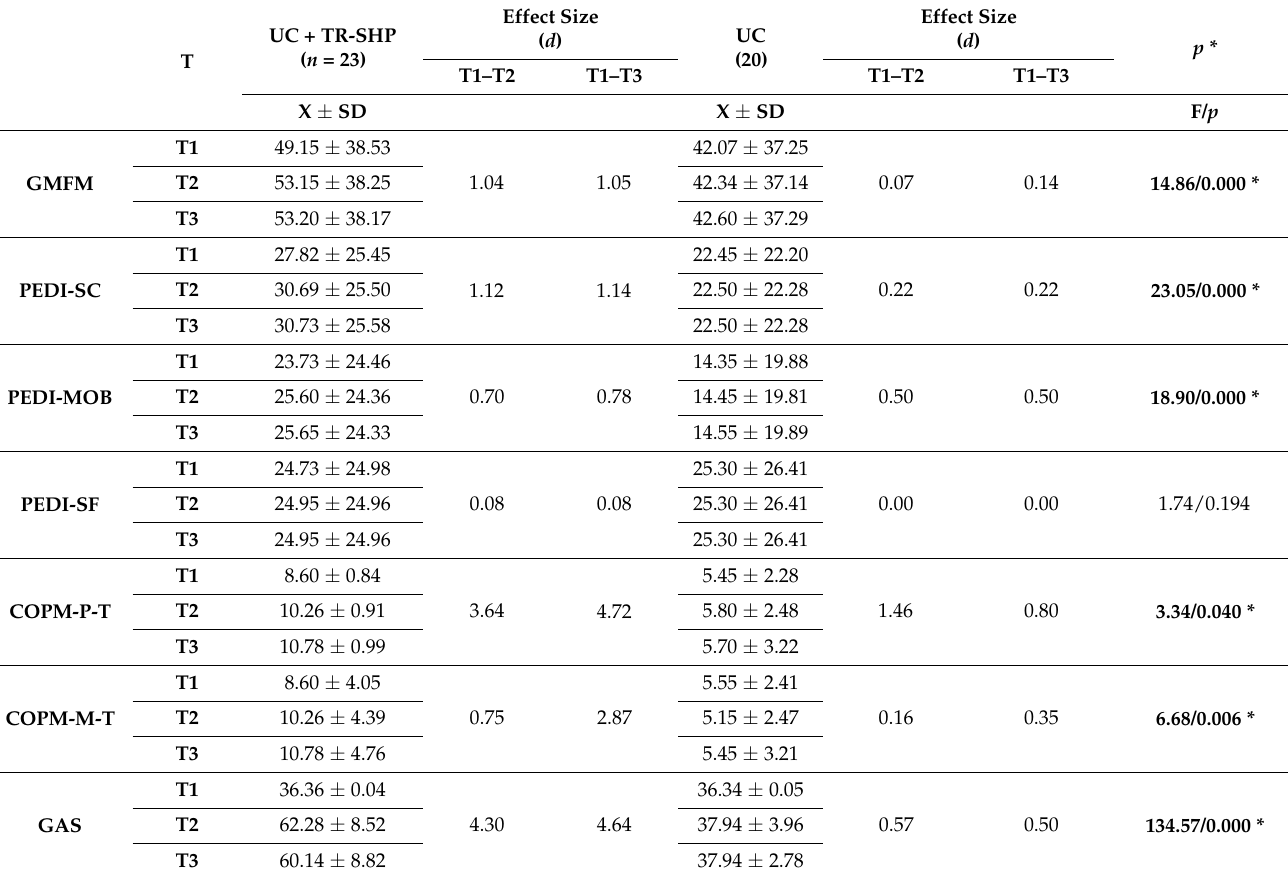
Table 5. Comparison of TR-SHP and UC motor function, activity and participation outcomes.